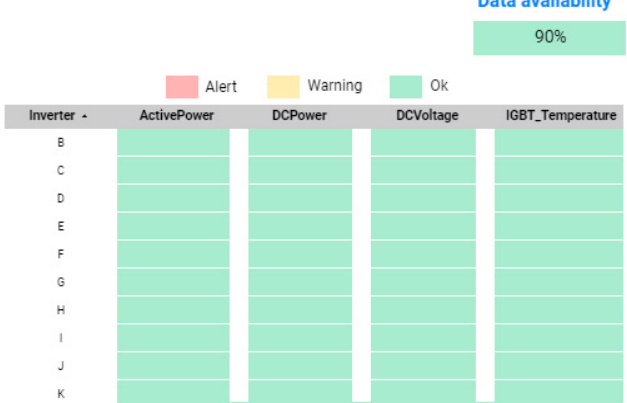
Figure 11. Inverter out-of-normality heatmap (patterns). For the selected period, an “Ok” (depicted in green color) was generated indicating the normality state for all inverters.